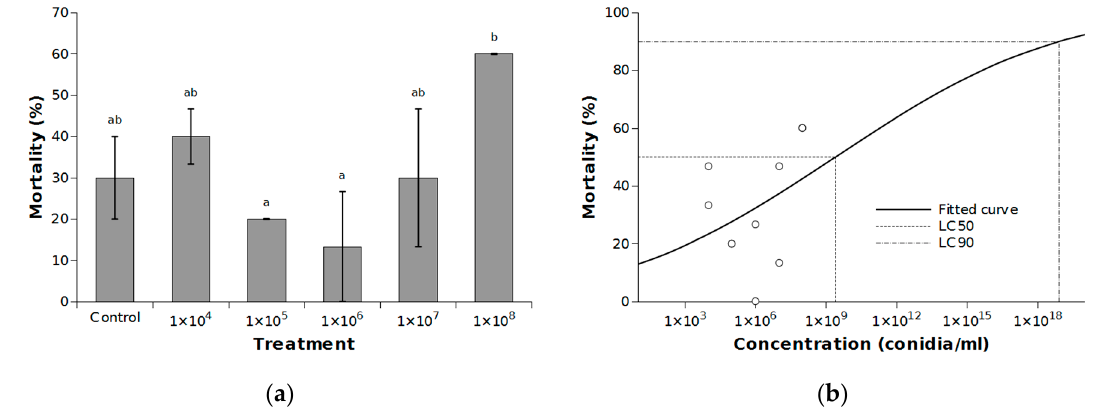
Figure 3. ( a ) Mean cumulative mortality (±SE) of Cydalima perspectalis (including mortality of malformed adults) treated with various concentrations of Isaria fumosorosea conidia. A generalized linear model was fitted and pairwise between treatment differences were tested using the least-square means. Different letters indicate significant differences between columns ( p < 0.05); ( b ) Log-probit regression line of concentration-mortality response of C. perspectalis to I. fumosorosea .